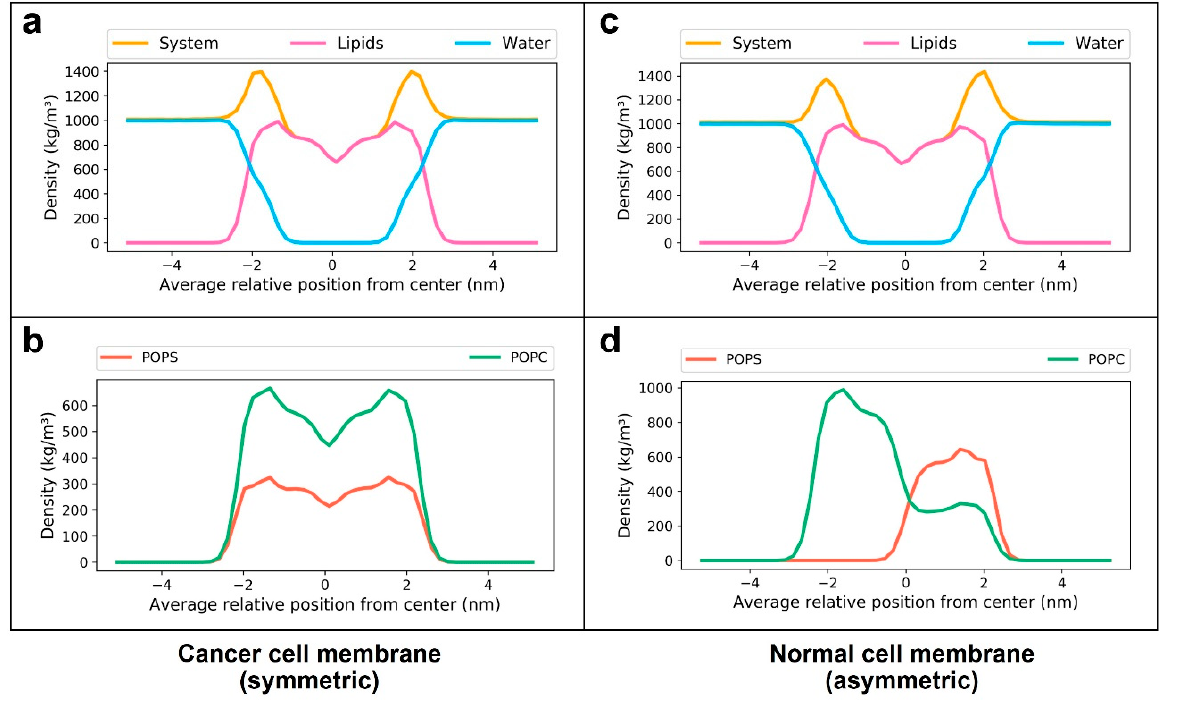
Figure 3. Densities of components of the equilibrated membrane systems: ( a , b ) cancer cell membrane and ( c , d ) normal cell membrane. The densities of the whole system (yellow), lipids (magenta) water (cyan), POPC (green) and POPS (orange) along the reaction coordinate “ z ” are shown. On the horizontal axis, the value 0 indicates the center hydrophobic core of the membrane, negative values indicate the outer (extracellular) leaflet and positive values indicate the inner (cytoplasmic) leaflet.